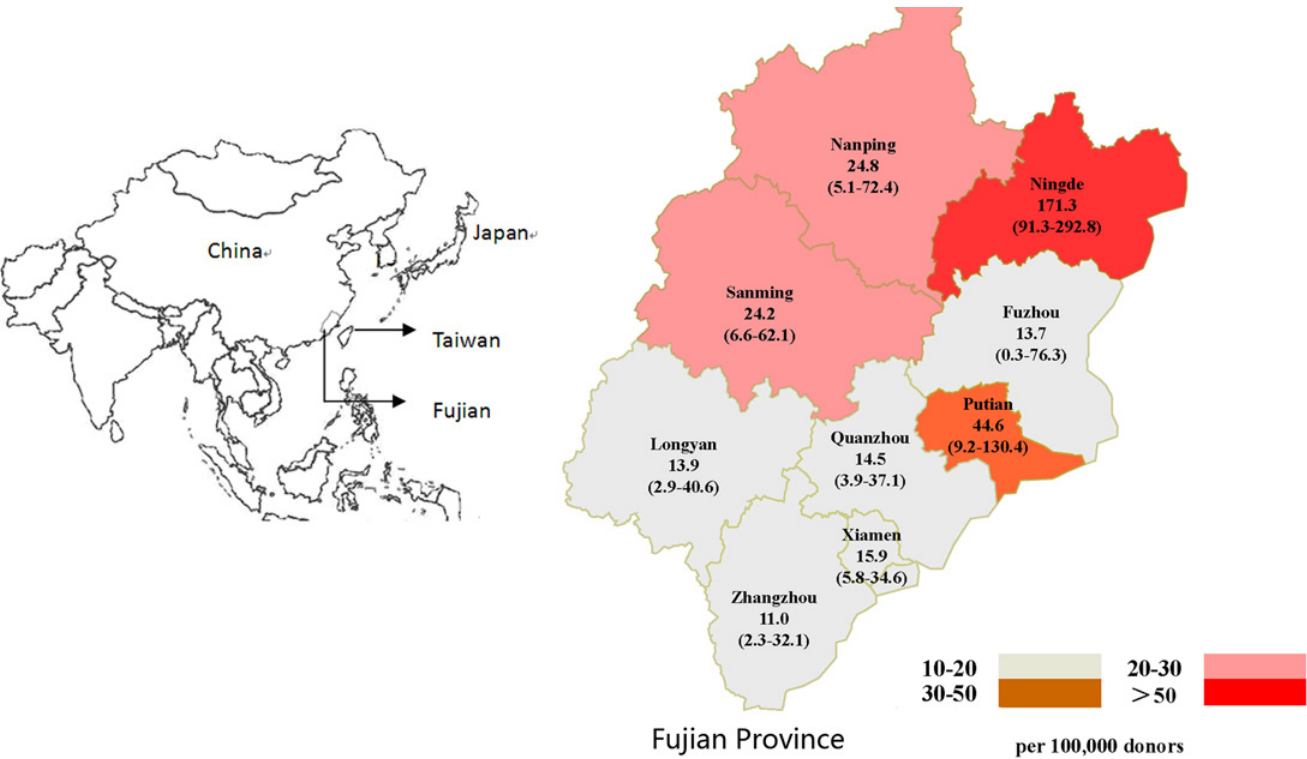
Fig 2. The geographic distribution of HTLV-1 infected donors among Fujian province. The prevalence of HTLV-1 in each city and its 95% CI was showed as 1 / 100,000.